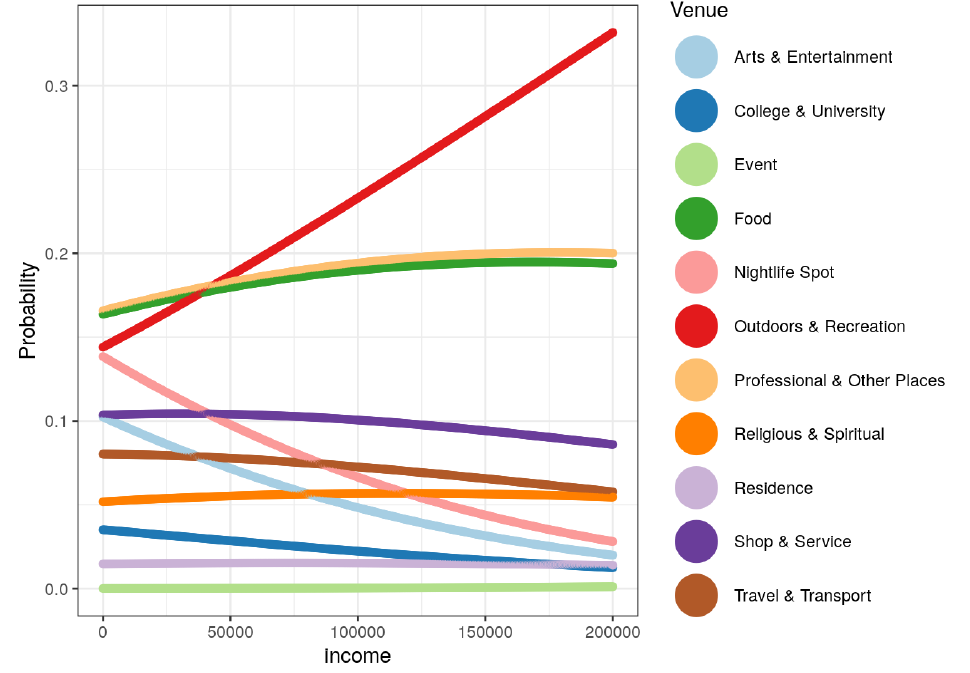
Figure 2. Multinomial Predicted Probabilities as a Function of